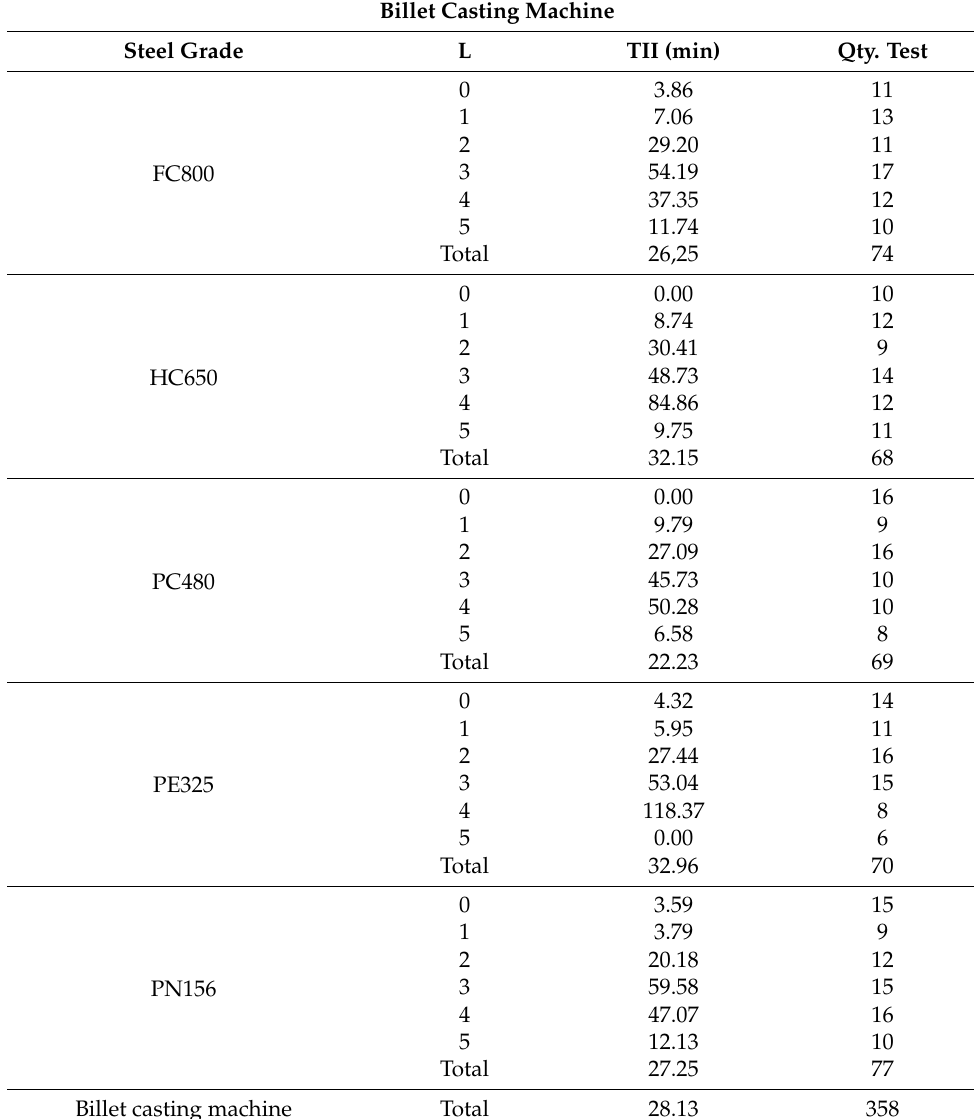
Table 3. TII in billet casting machine, grouped according to steel classes and active